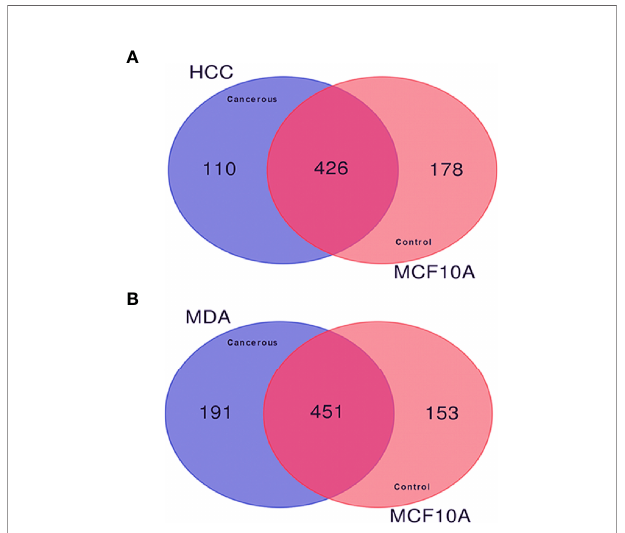
FIGURE 2 | Comparison of the membrane-associated proteins identi fi ed in breast cancer (HCC-1954 and MDA-MB-231) versus benign control (MCF- 10A) cell lines by GeLC-MS/MS analysis. Proteins from 4 biological replicates of each breast cancer cell line were combined for this comparison. (A) Venn diagram depicting the comparison of HCC-1954 vs. MCF-10A cells, of which 426 proteins were commonly identi fi ed, while 110 and 178 proteins were uniquely identi fi ed in HCC-1954 and MCF-10A, respectively. (B) Venn diagram depicting the comparison of MDA-MB-231 vs. MCF-10A cells, of which 451 proteins were commonly identi fi ed, while 191 and 153 proteins were uniquely identi fi ed in MDA-MB-231 and MCF-10A,